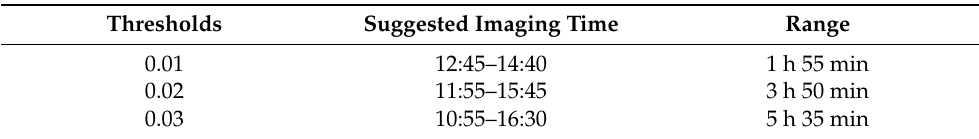
Table 7. Proper imaging windows for different thresholds of the NDVI changes caused by diurnal factors (when solar noon is the standard imaging time).